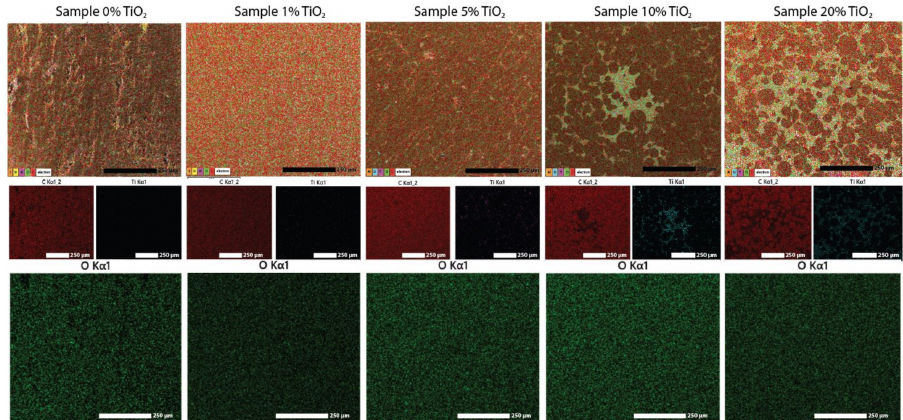
Figure 6. The presence of elements in the samples by EDS analysis. The images correspond to 0%, 1%, 5%, 10% and 20% of added TiO 2 into PMMA. First colon shows the distribution of the following elements: orange—S, yellow—Si, purple–Al, green—O and red—C. Second colon corresponds only to C and